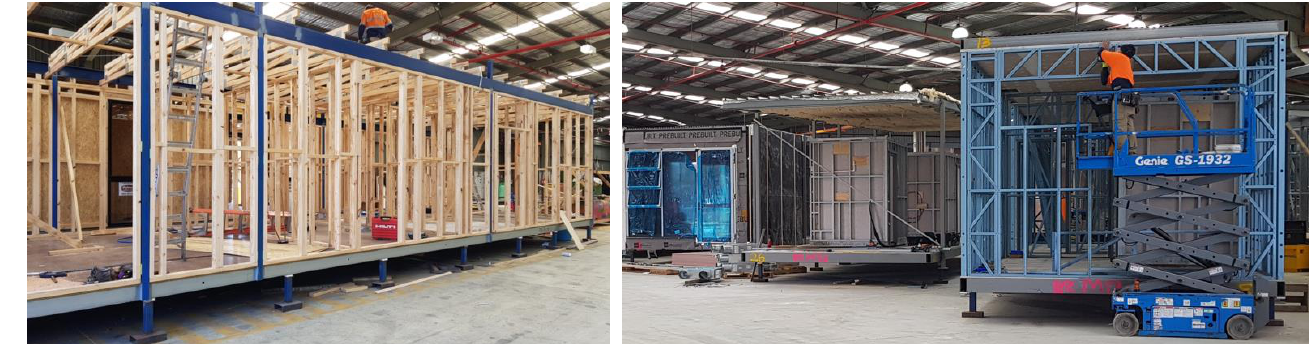
Figure 1. A steel modular unit with softwood wall frames ( left ) and a steel corner supported modular unit with a cold formed light-gauge steel wall frame ( right ), showing various materials used in prefabricated construction.